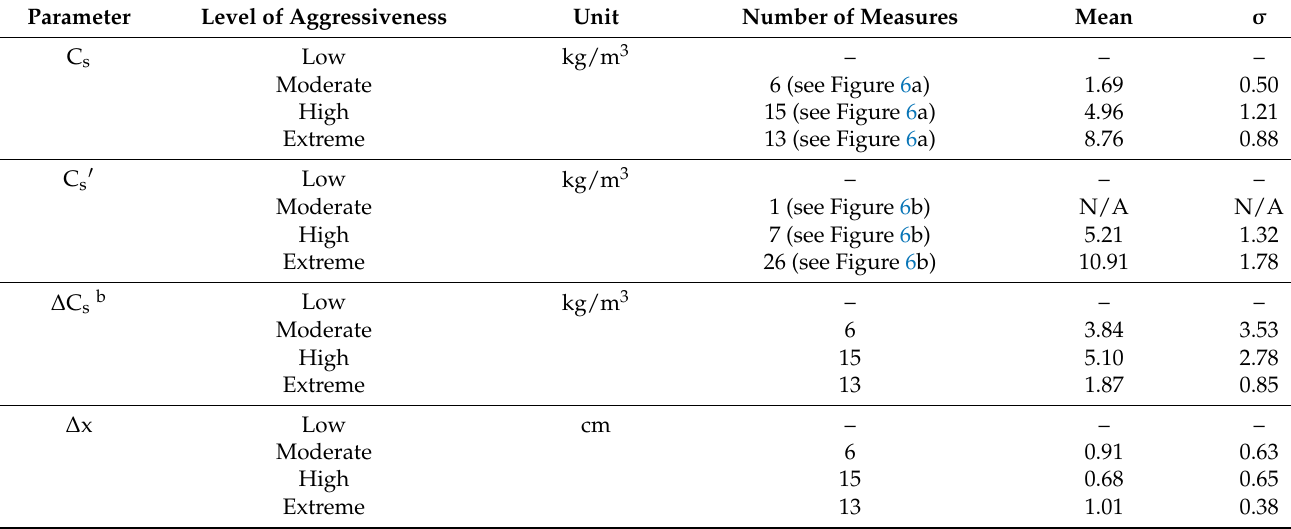
Table 2. C s , C s ‘, ∆ C s , and ∆ x values for each level of aggressiveness a